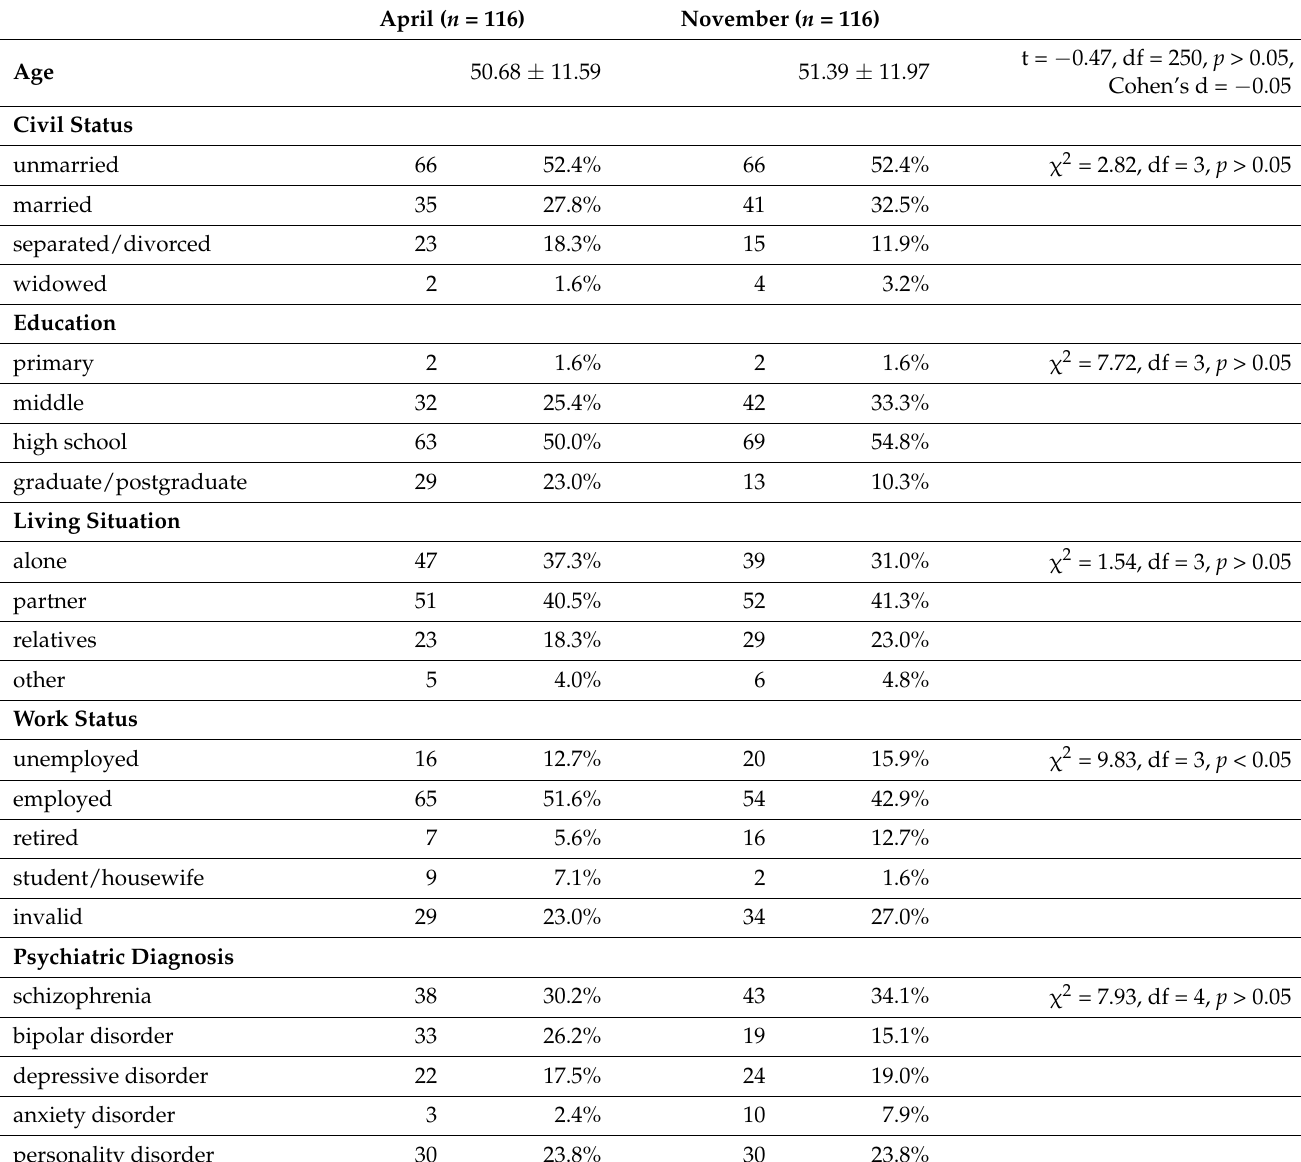
Table 1. Characteristics of participants in